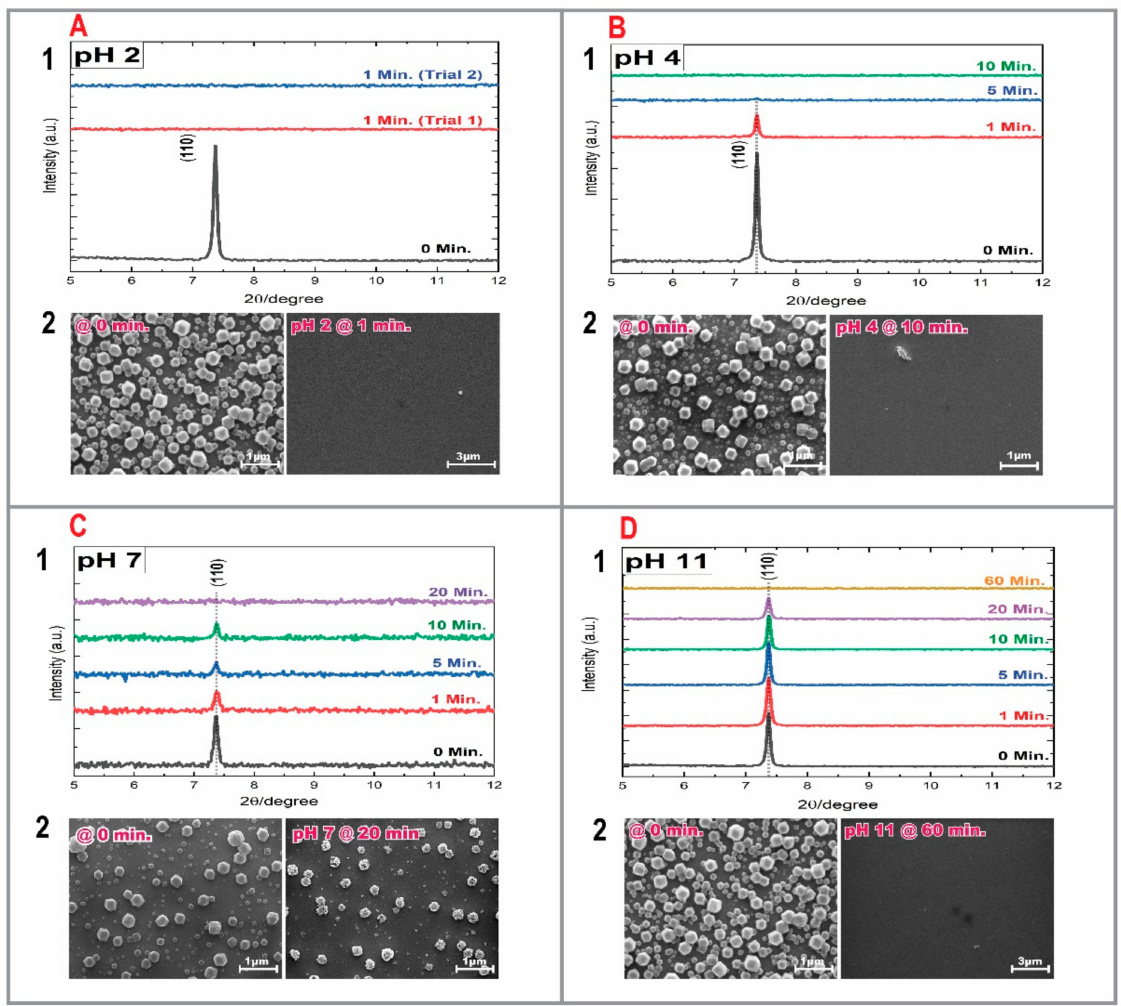
Figure 2. XRD patterns and SEM images of ZIF-8 SURMOF films immersed in a: ( A ) pH 2 solution, ( B ) pH 4 solution, ( C ) pH 7 solution, and ( D ) pH 11